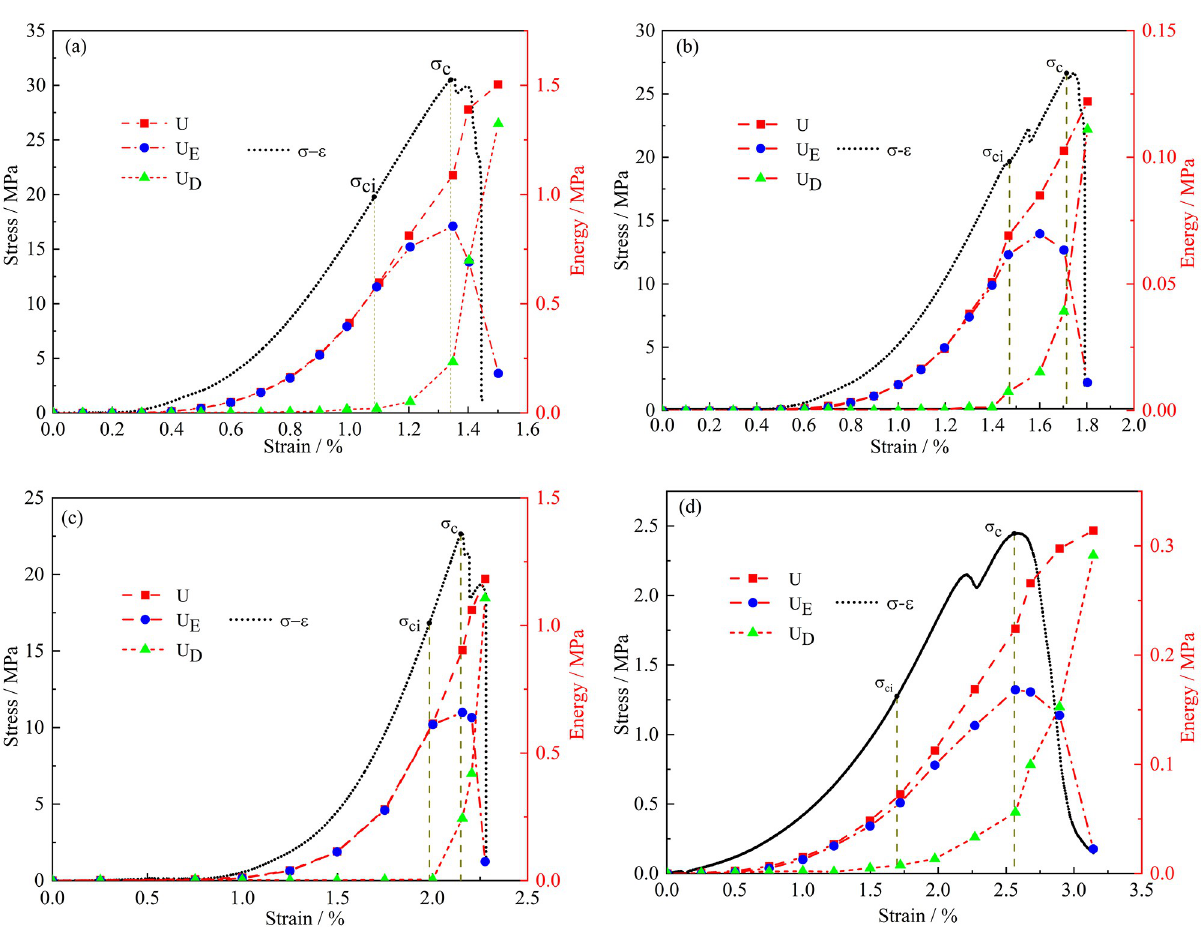
Fig 2. Stress-strain curve and energy evolution law of sandstone with different freeze-thaw cycles. (a) N = 20 (b) N = 40 (c) N = 60 (d) N = 80 .